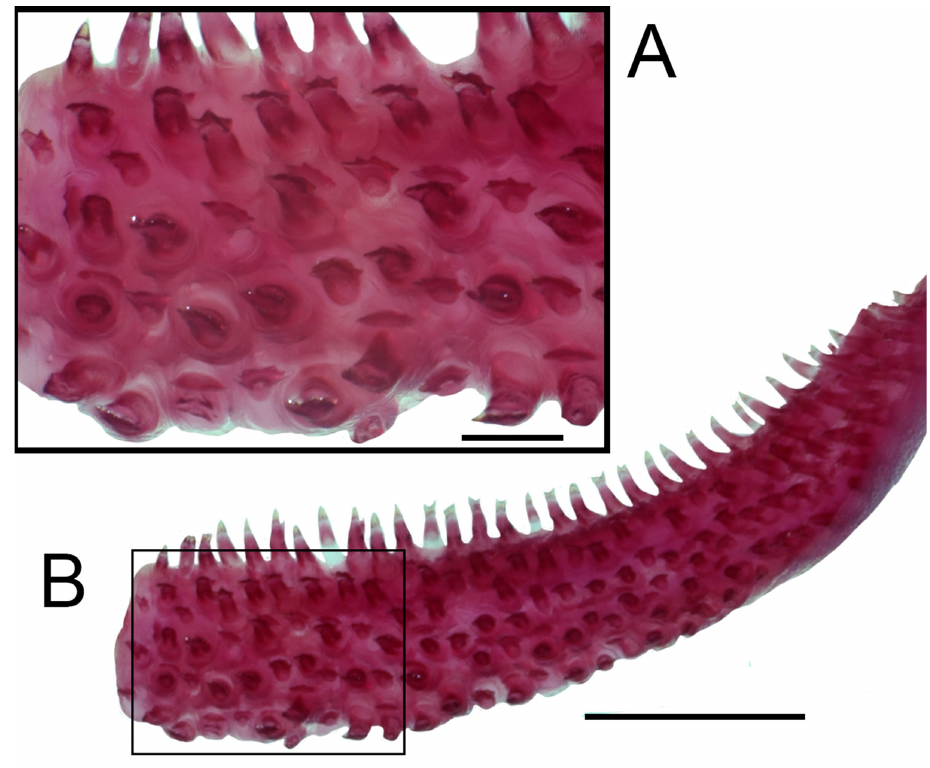
FIGURE 3 | Left dentary of Phenacorhamdia suia , paratype, LBP 15886, 51.3 mm SL (c&s). A. Dorsal view of medial portion of dentary teeth (scale bar = 0.1 mm) and B. Dorsal view of entirely dentary teeth (scale bar = 0.5